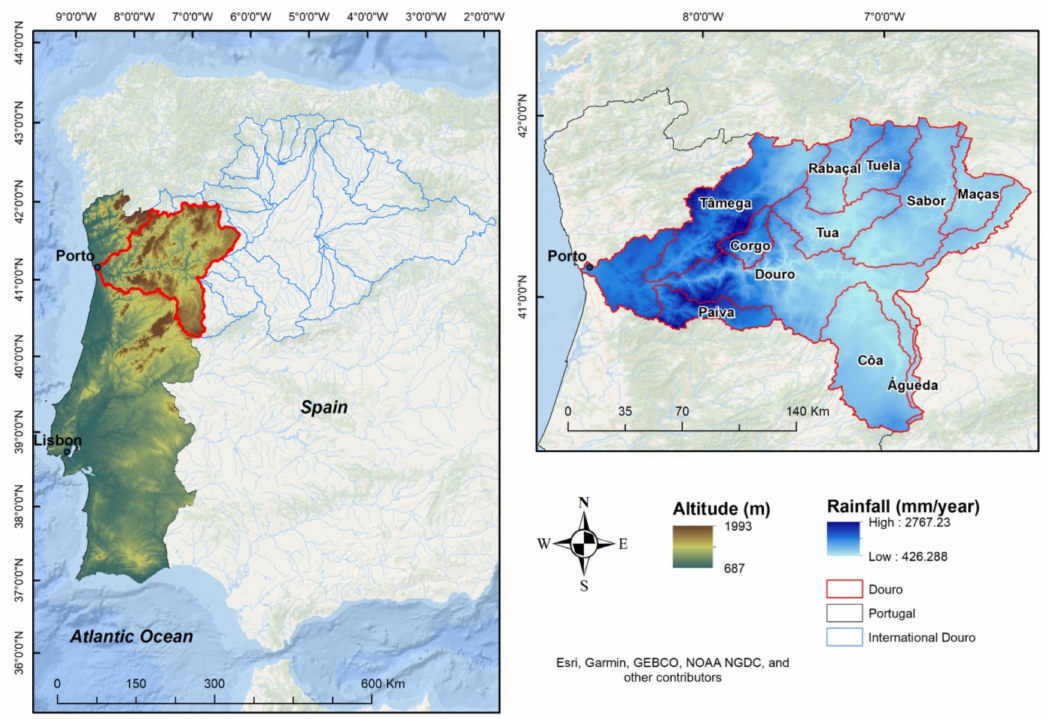
Figure 1. ( a ) Location map illustrating the Douro River Basin and evidencing the Portuguese side over the topographic map. ( b ) Portuguese side of the Douro River Basin evidencing the most important tributary catchments and spatial distribution of annual